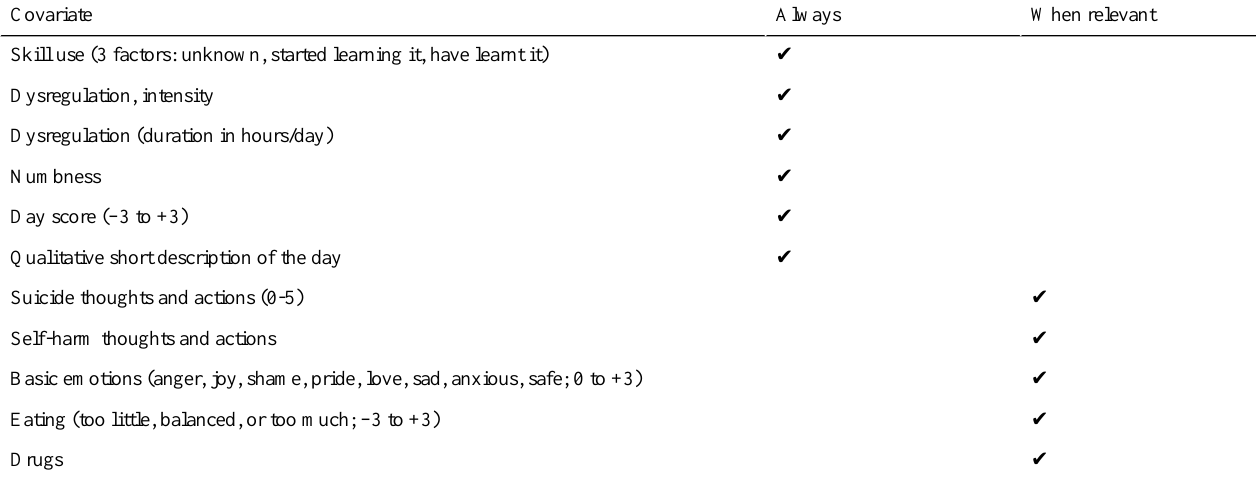
Table 2. Outcomes collected daily from the mobile phone–based or paper diary.